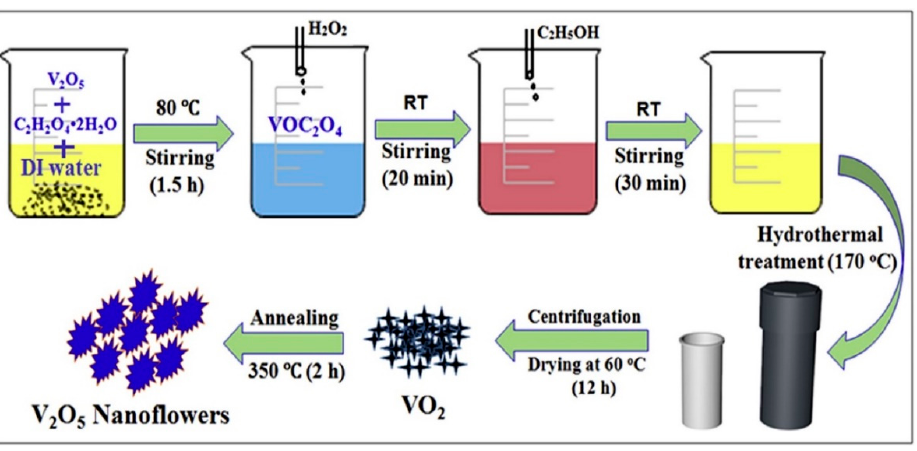
Figure 4. Schematic of preparation of flower-like V 2 O 5 via hydrothermal method [54].